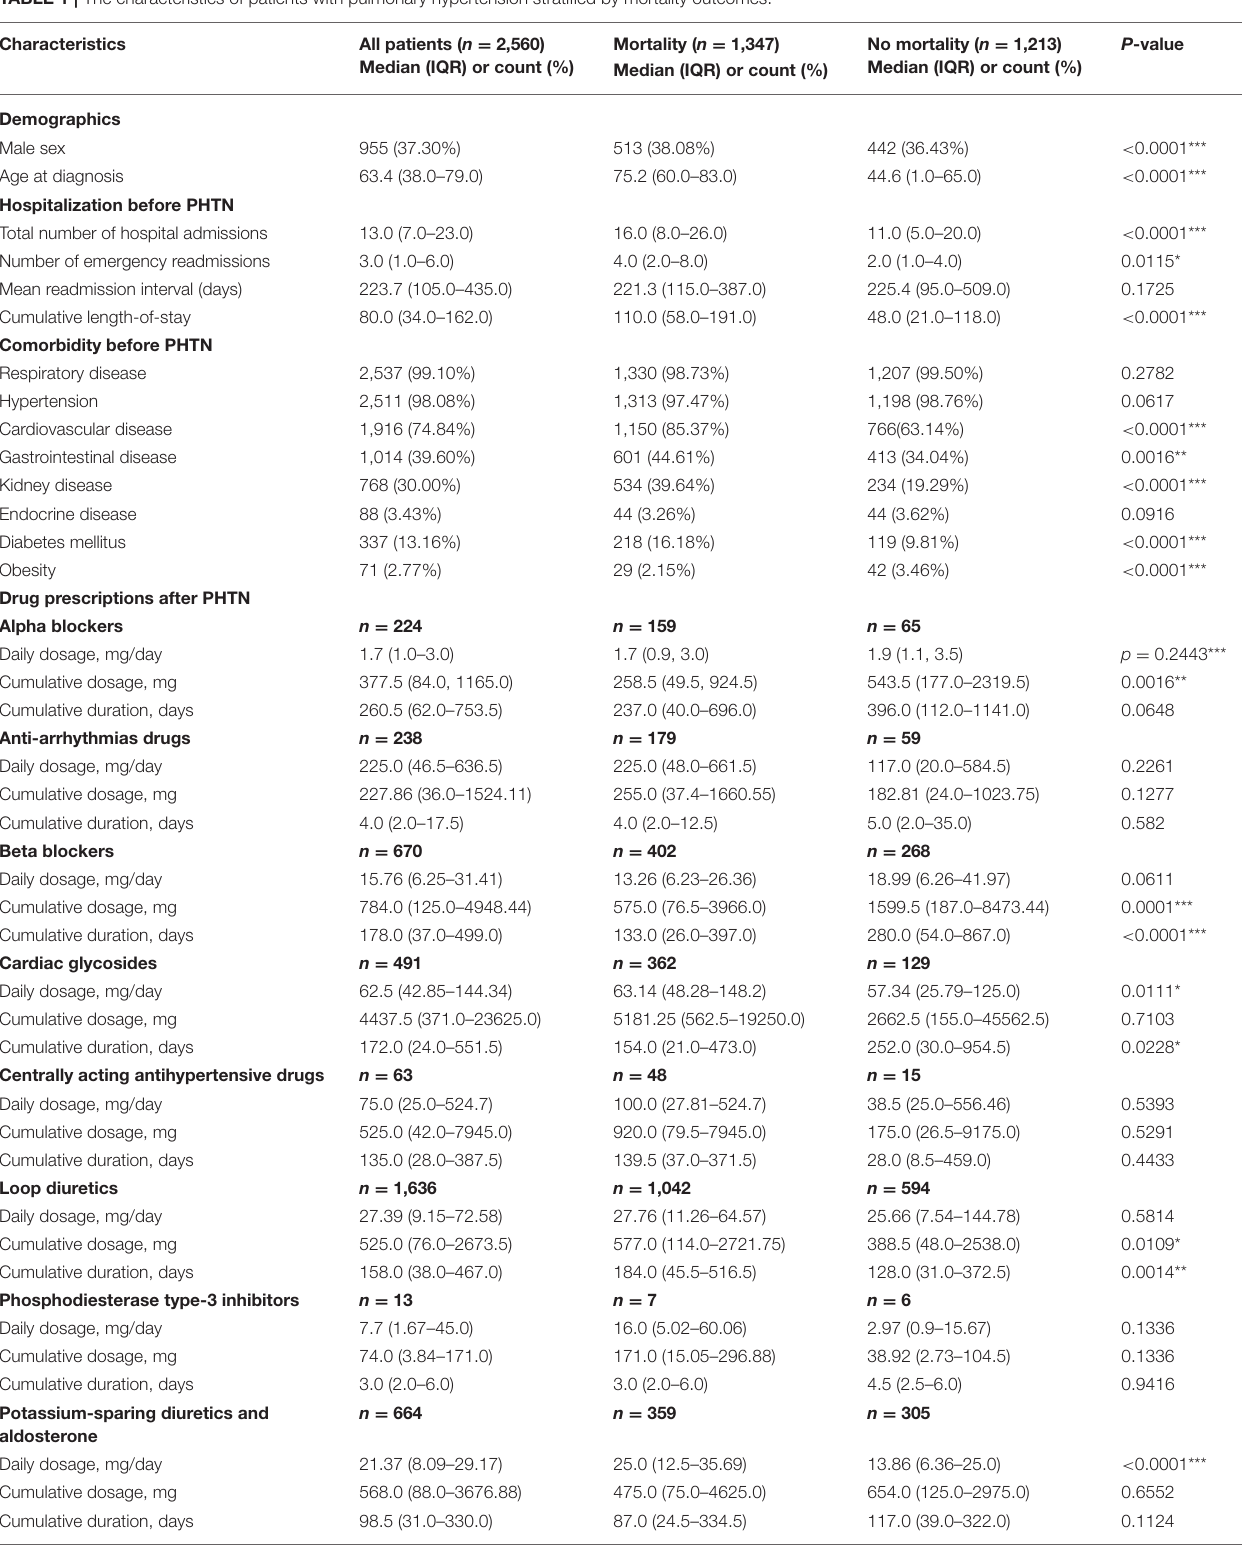
TABLE 1 | The characteristics of patients with pulmonary hypertension stratified by mortality outcomes.